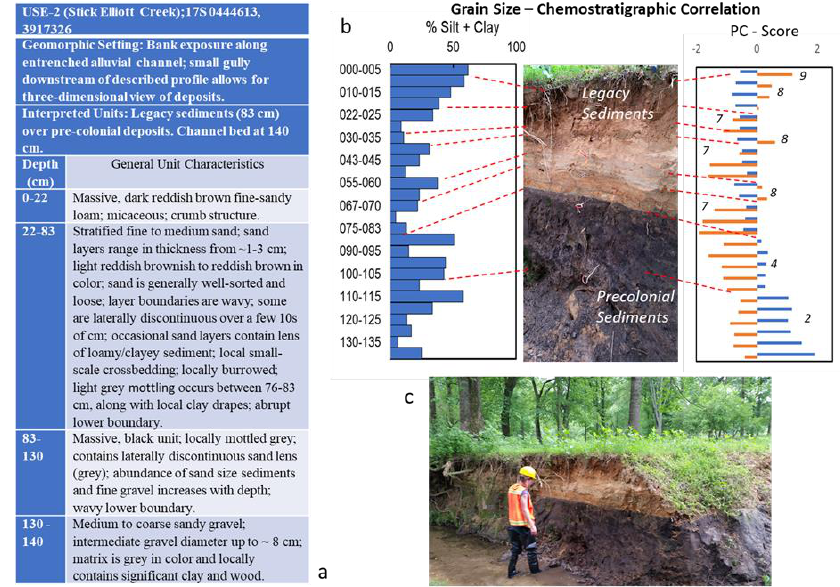
Figure 3. ( a ) Field descriptions, ( b ) relationship between fine sediment content and PCA scores, and ( c ) photograph of the stratigraphic section analyzed at Site USE 2. Numbers shown within the plot of PC scores refer to chemostratigraphic units. These data are provided for the other sites in Figures S1 – S3.